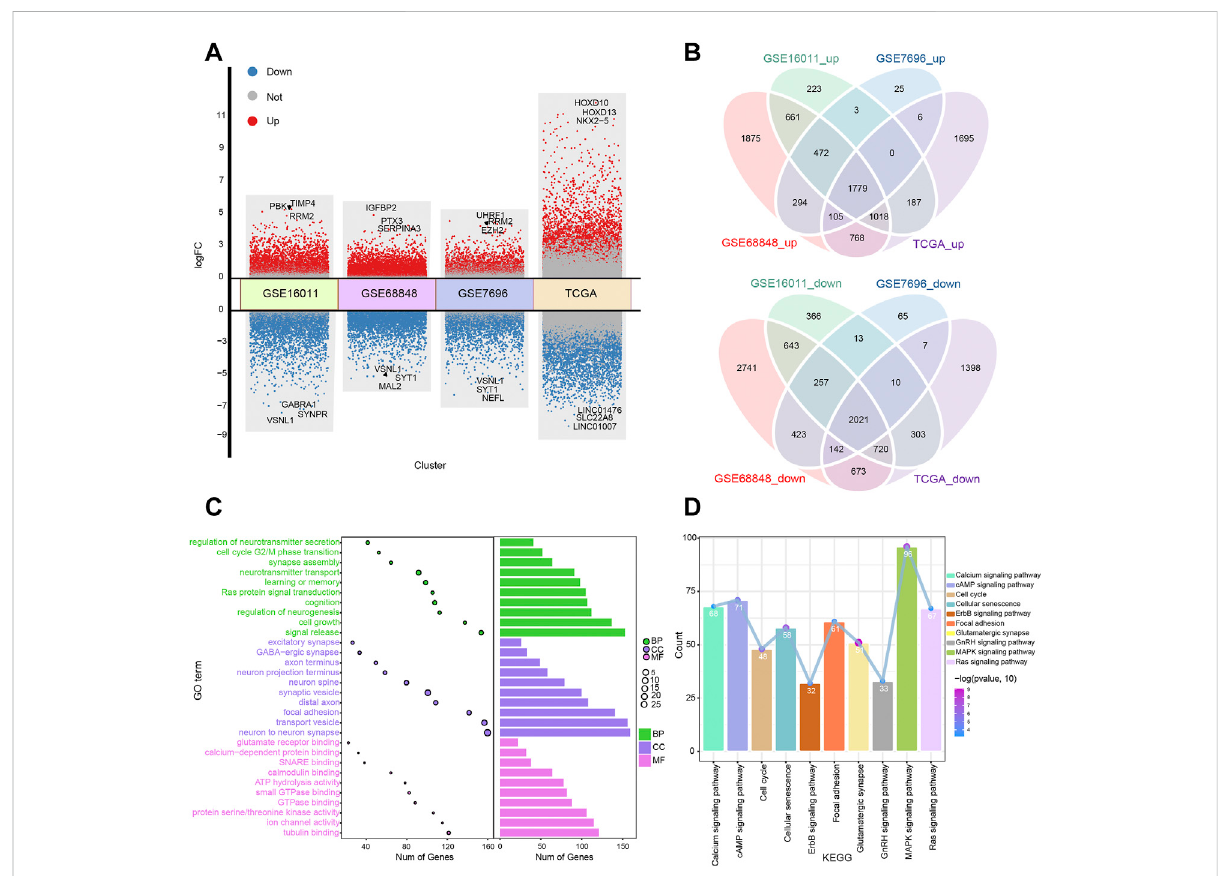
FIGURE 2 Differentialexpressionanalysisandenrichmentanalysisinglioblastoma(GBM). (A) Volcanoplotsofdifferentiallyexpressedgenes(DEGs)infour datasets (GSE16011, GSE68848, GSE7696, and TCGA). Red dots indicate upregulated DEGs, grey dots indicate not-regulated DEGs, and blue dots indicate downregulated DEGs. (B) Venn diagramoftheintersected DEGs offourdatasets,including commonly up/downregulated DEGs. (C)